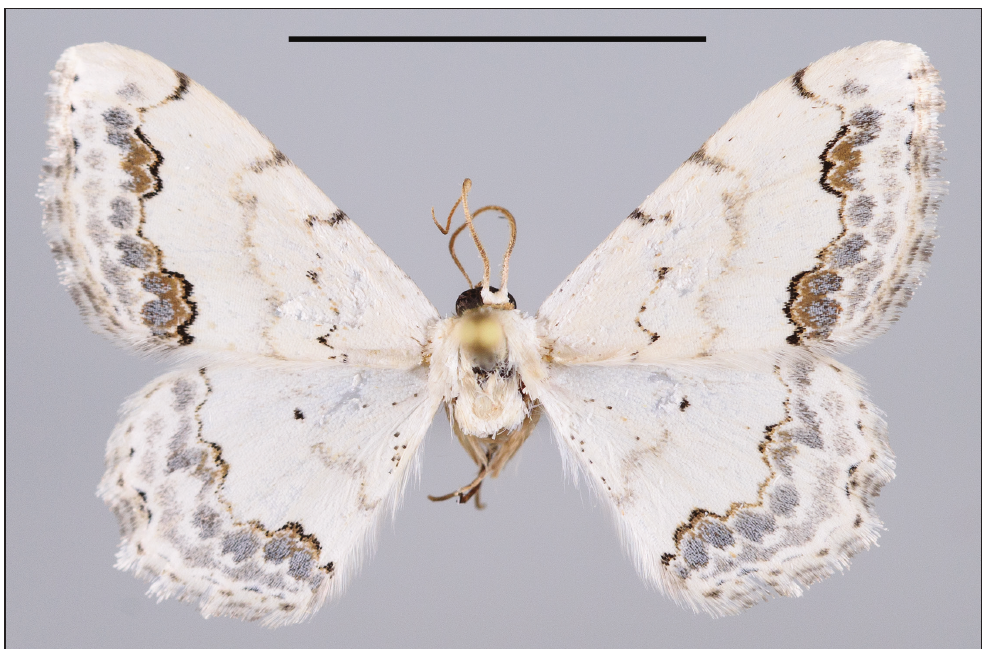
Figure 2. Male of S. orientalis from Romania, Enisala fortress, Tulcea county, 4.ix.2015, prep. genit. 2318/ Dincă. Scale bar is 10 mm. Photo: V. Dincă.